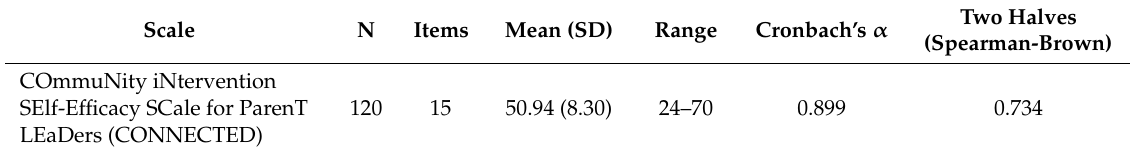
Table 2. Cronbach’s alpha and split-half estimates of the scale.